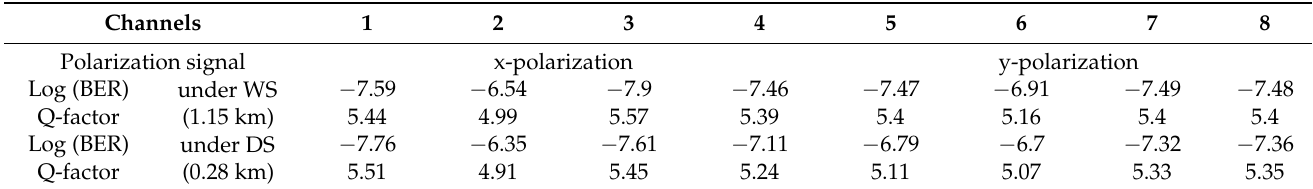
Table 7. Comparison between present work and previous recent works.